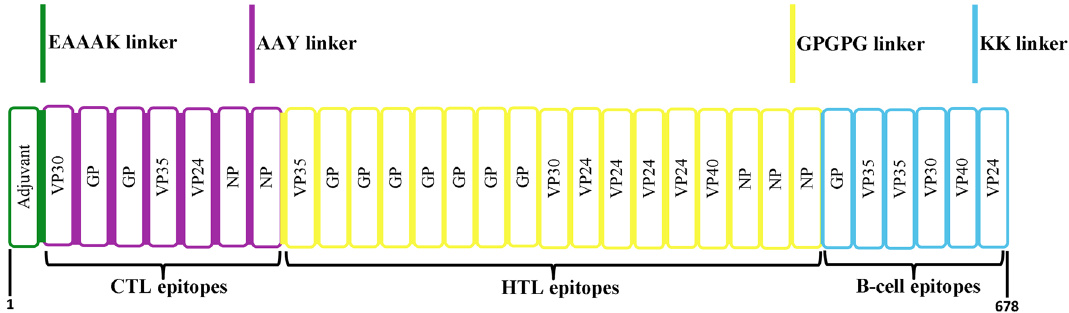
Figure 2. A schematic depiction of the final multi-epitope vaccine